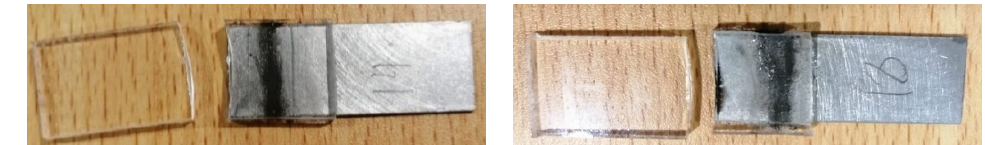
Figure 9. Failure of the specimens welded with the parameters sets 14 ( left ) and 18 ( right )—failure in the PMMA part after tensile testing.